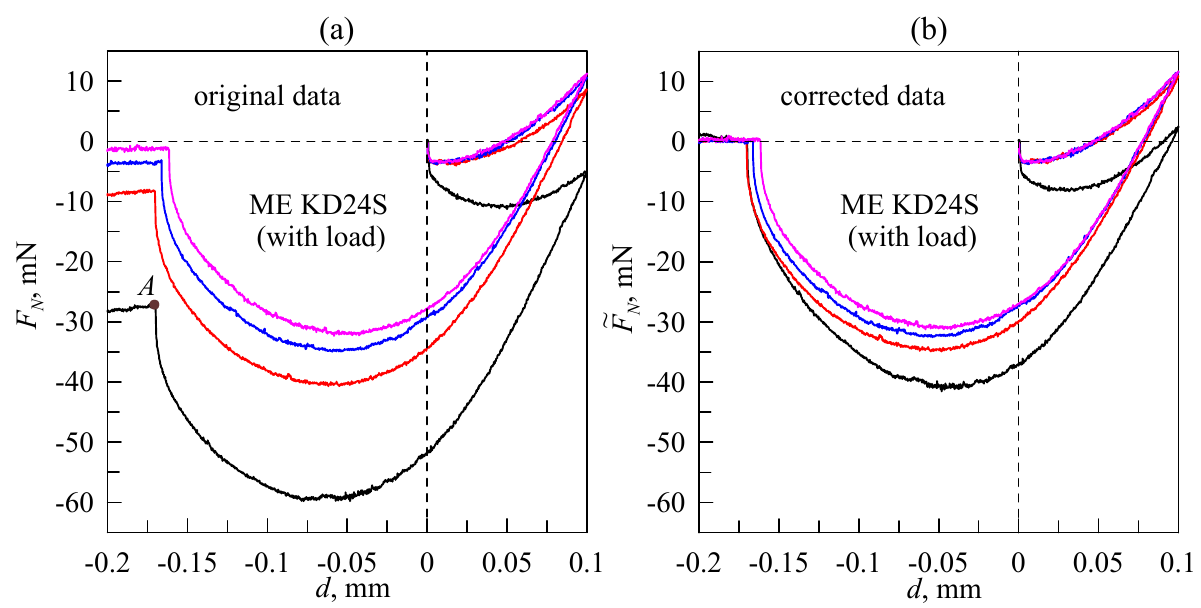
Figure 6. Dependencies of the normal force ( F N ) on the indentation depth ( d ) obtained during the indentation of a steel spherical indenter with a radius of R = 30 mm into a TARNAC CRG N0505 rubber substrate with a thickness of h = 5 mm. ( a ) The original data measured in four experiments performed under the same conditions. ( b ) The corrected dependencies after subtraction of the supposed signal drift. Curves, corresponding to the same experiments, are denoted by the same color in both panels.